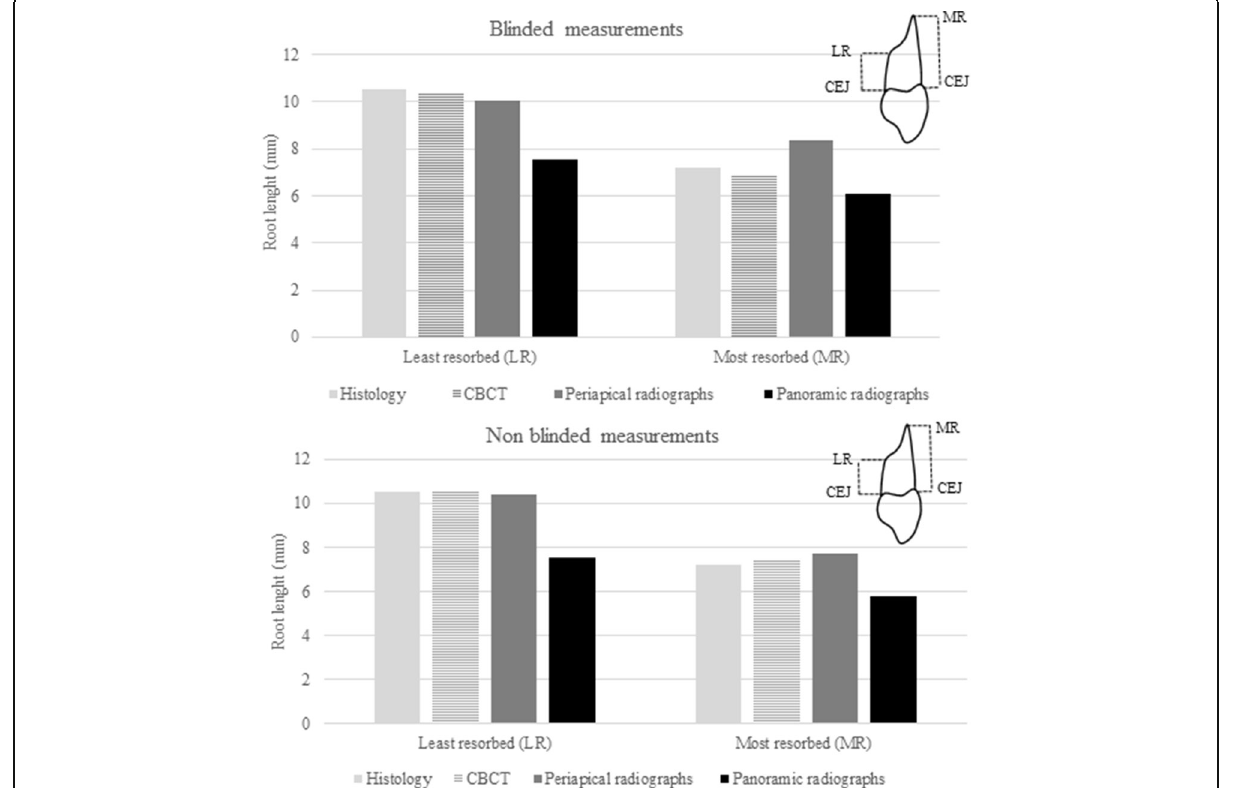
Fig. 4 Blinded and not blinded measurements of the least resorbed (LR) and most resorbed (MR) side of the root in millimeters measured on histology (gold standard), cone beam computed tomography (CBCT), periapical radiographs, and panoramic radiograph (PAN). PAN differed significantly ( p < 0.05) in both blinded and not blinded measurements compared to